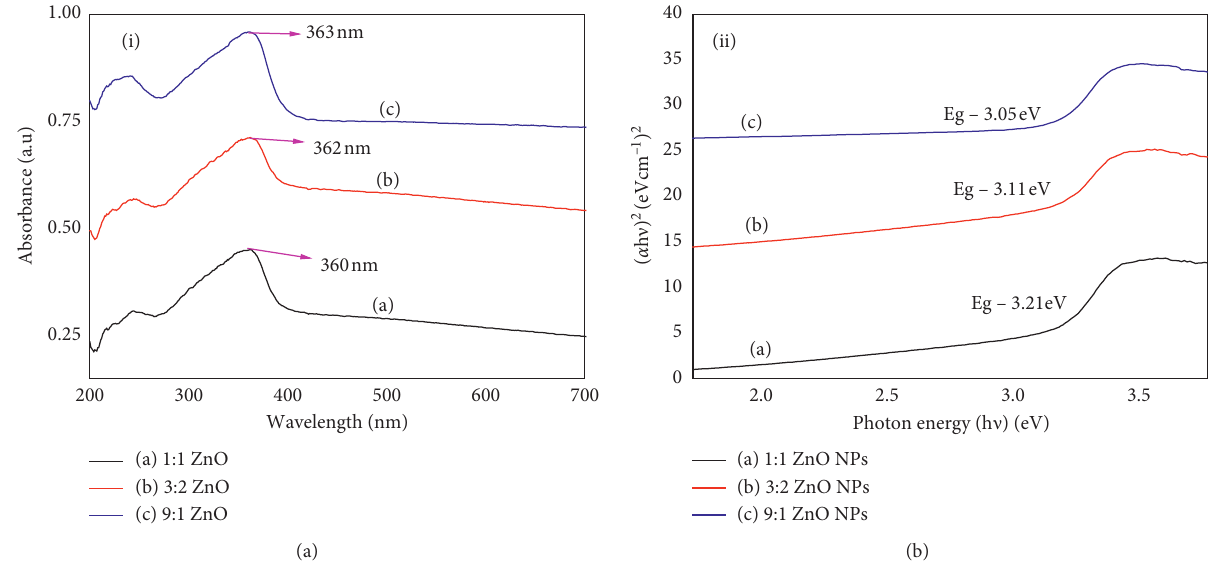
Figure 7: (a) Absorption spectra and (b) Tauc plot of biosynthesized ZnO nanoparticles at different ratios by